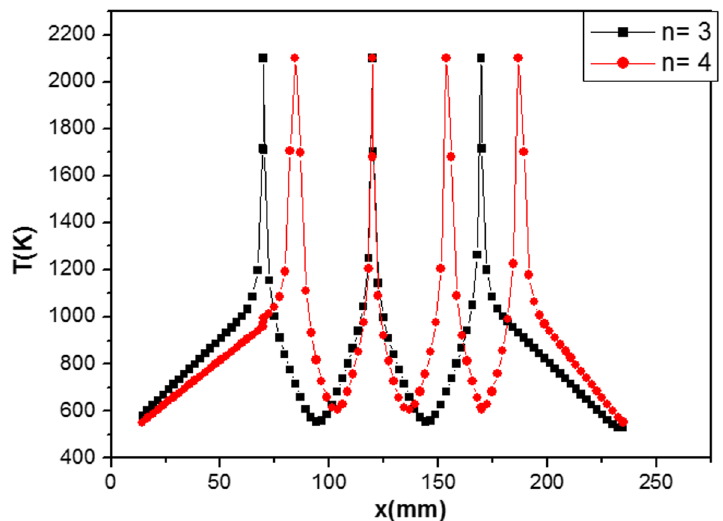
Fig. 3 Distribution of T as a function of x for z